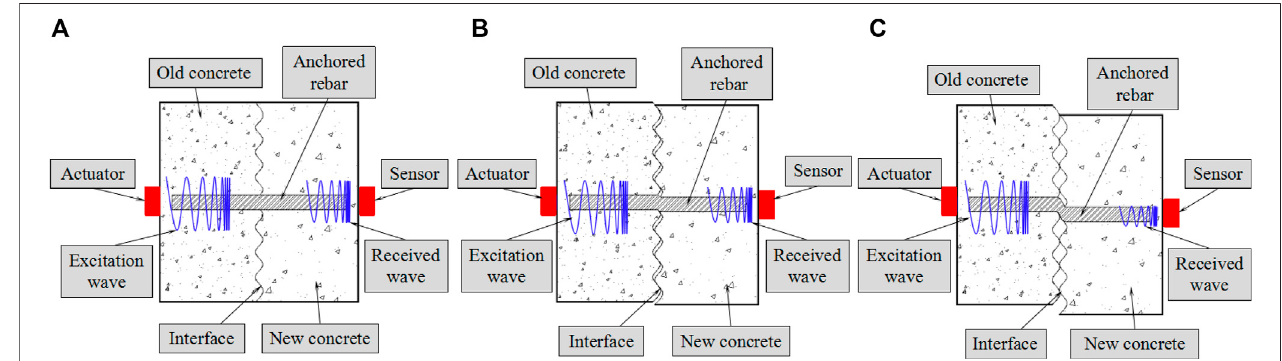
FIGURE 2 | Stress-wave-based active sensing principle for the interfacial bond slip process: (A) Stress waves propagating before bond slip; (B) Stress waves propagating after interfacial bond slip; (C) Stress waves propagating after interface separation.